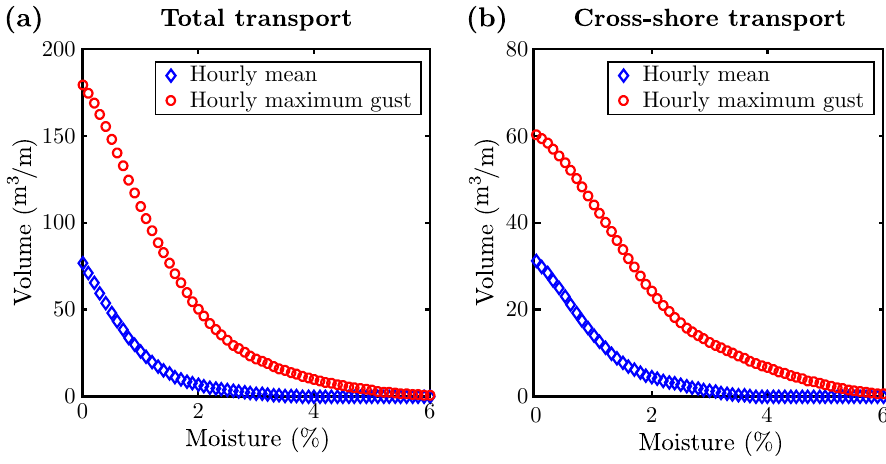
Figure 11. ( a ) Predicted Total and ( b ) Cross-Shore transported volume of sand (m 3 /m), due to aeolian sand transport from the intertidal beach at Egmond Beach for the period March 2009–March 2010, for several surface moisture content values. We calculated the transport using the Kawamura equation (Equation (2)) and considering the moisture effect in the threshold shear velocity ( U ∗ tm ) (Equation (4)). The input data correspond to the hourly mean wind speed and gust wind speed, for the time in which sand transport was observed and the proportionality factor ( P = 3) to obtain annual